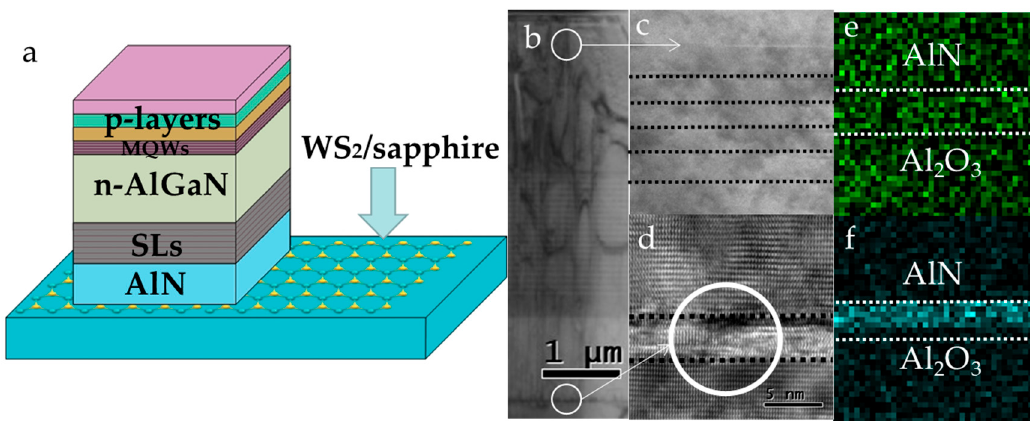
Figure 3. Characterizations of conventional AlGaN-based deep ultraviolet (DUV) light emitting diodes (LEDs) grown on WS 2 /sapphire substrates. ( a ) Schematic illustration of the DUV LED structure. ( b ) Cross-sectional scanning transmission electron microscopy (STEM) image of heterojunction LEDs; ( c ) Al 0.5 Ga 0.5 N/Al 0.6 Ga 0.4 N MQWs; and ( d ) the AlN/WS 2 /sapphire interface of the as-grown DUV LED. ( e ) Energy dispersive X-Ray spectroscopy (EDX) mapping of S; and ( f ) W element showing the WS 2 gap between AlN and sapphire.